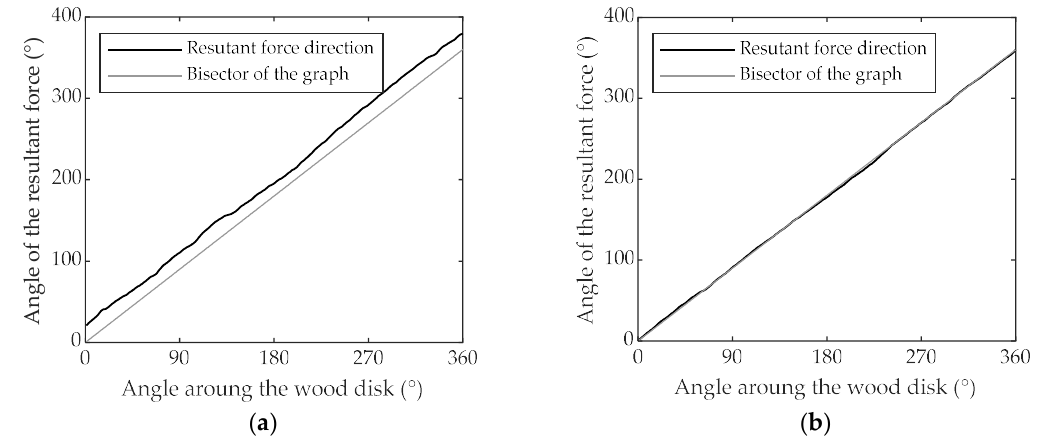
Figure 7. Resultant force angle on PTFE-machined up-milling with a depth of cut of: ( a ) 0.3 mm; ( b ) 1.5 mm.